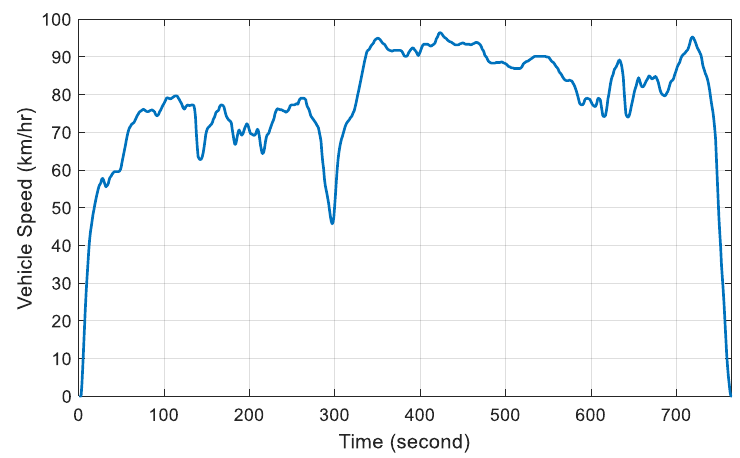
Figure 4. FTP-75 highway driving cycle.